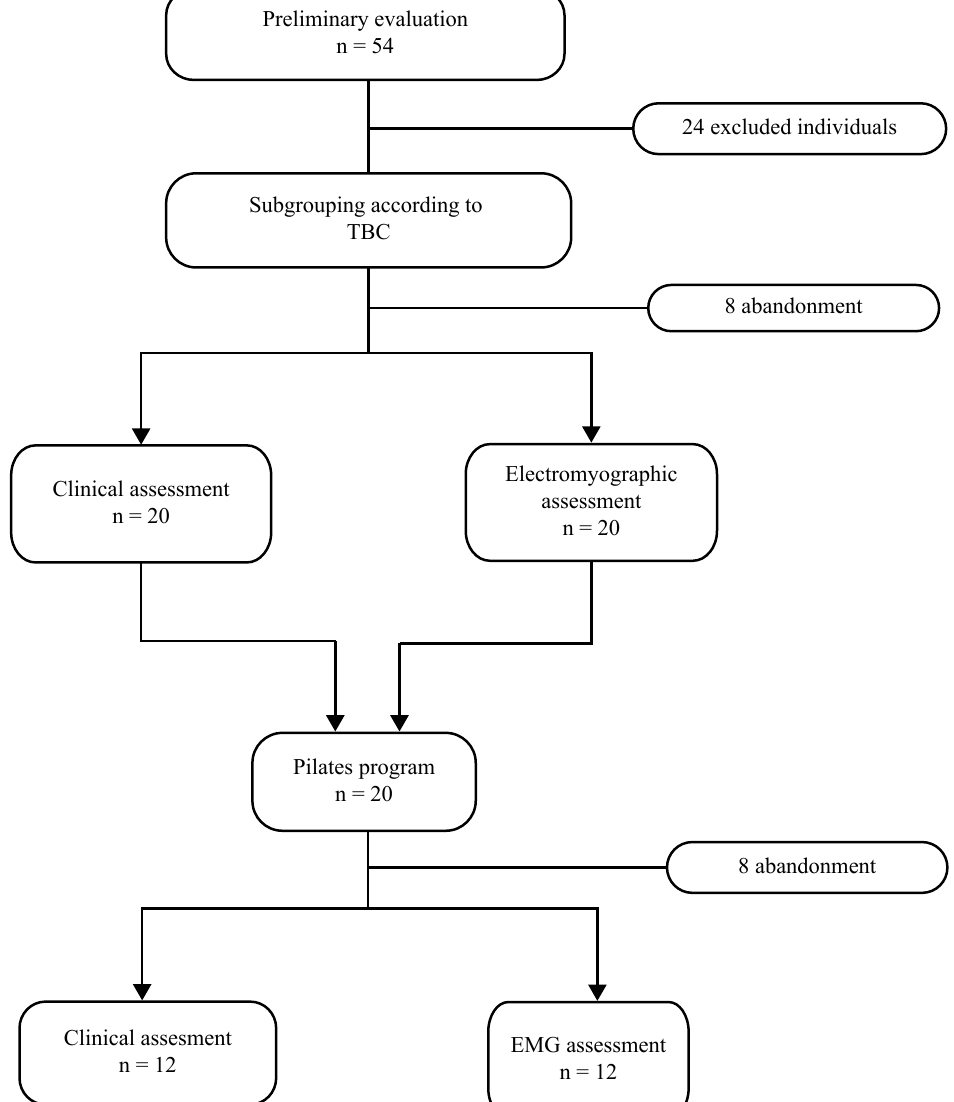
Figure 1. Flow chart with the main steps of